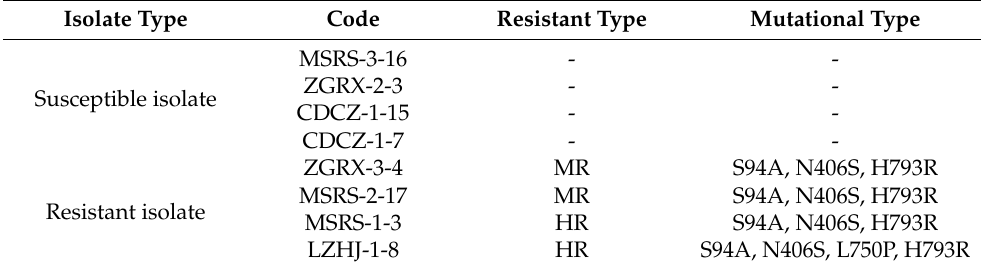
Table 4. Statistics of point mutation information in CYP51